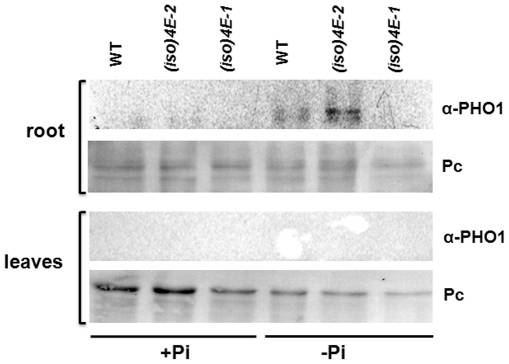
Western blot analysis of PHO1 protein levels in seedlings grown under phosphate sufficiency (+Pi) or deficiency (−Pi).One week -old seedlings from WT, (iso)4E-1 and (iso)4E-2 lines were transferred to liquid medium containing 1 mM (+Pi) or 10 µM (−Pi) phosphate and grown for an additional week. After that roots and leaves were carefully separated and total proteins extracted from each tissue. Thirty micrograms of total proteins were used for each sample. A reacting band corresponding to the molecular weight of PHO1 was detected only for roots of WT and the (iso)4E-2 overexpressing line in the –Pi condition. As protein loading control, a region of the Ponceau stained membrane is shown in the lower panel of each tissue (Pc).